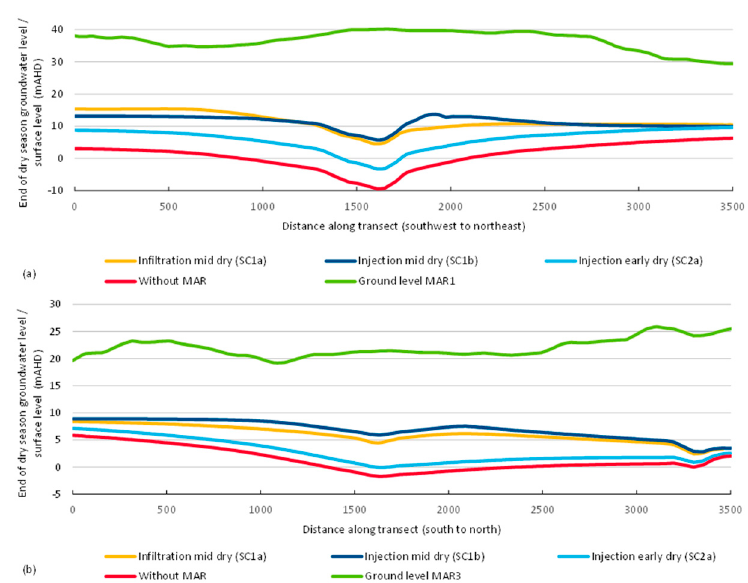
Figure 4. Example cross-section of hydraulic head response under infiltration (SC1a) or injection (SC1b, SC2a) type MAR scenarios at ( a ) MAR1 and ( b ) MAR3 for end of dry season groundwater level (30 November 2009). SC1a and SC1b Recharge occurs during the mid-dry season, recharge triggered by dry season minimum groundwater level of MAR1~18 mAHD, MAR3~10 mAHD. SC2a Recharge occurs in the early dry season, with constant groundwater level maintained from 1 April to 1 July, MAR1 constant head of 36 mAHD, MAR3 constant head of 20 mAHD. Location of the cross-section is shown on Figure 5.